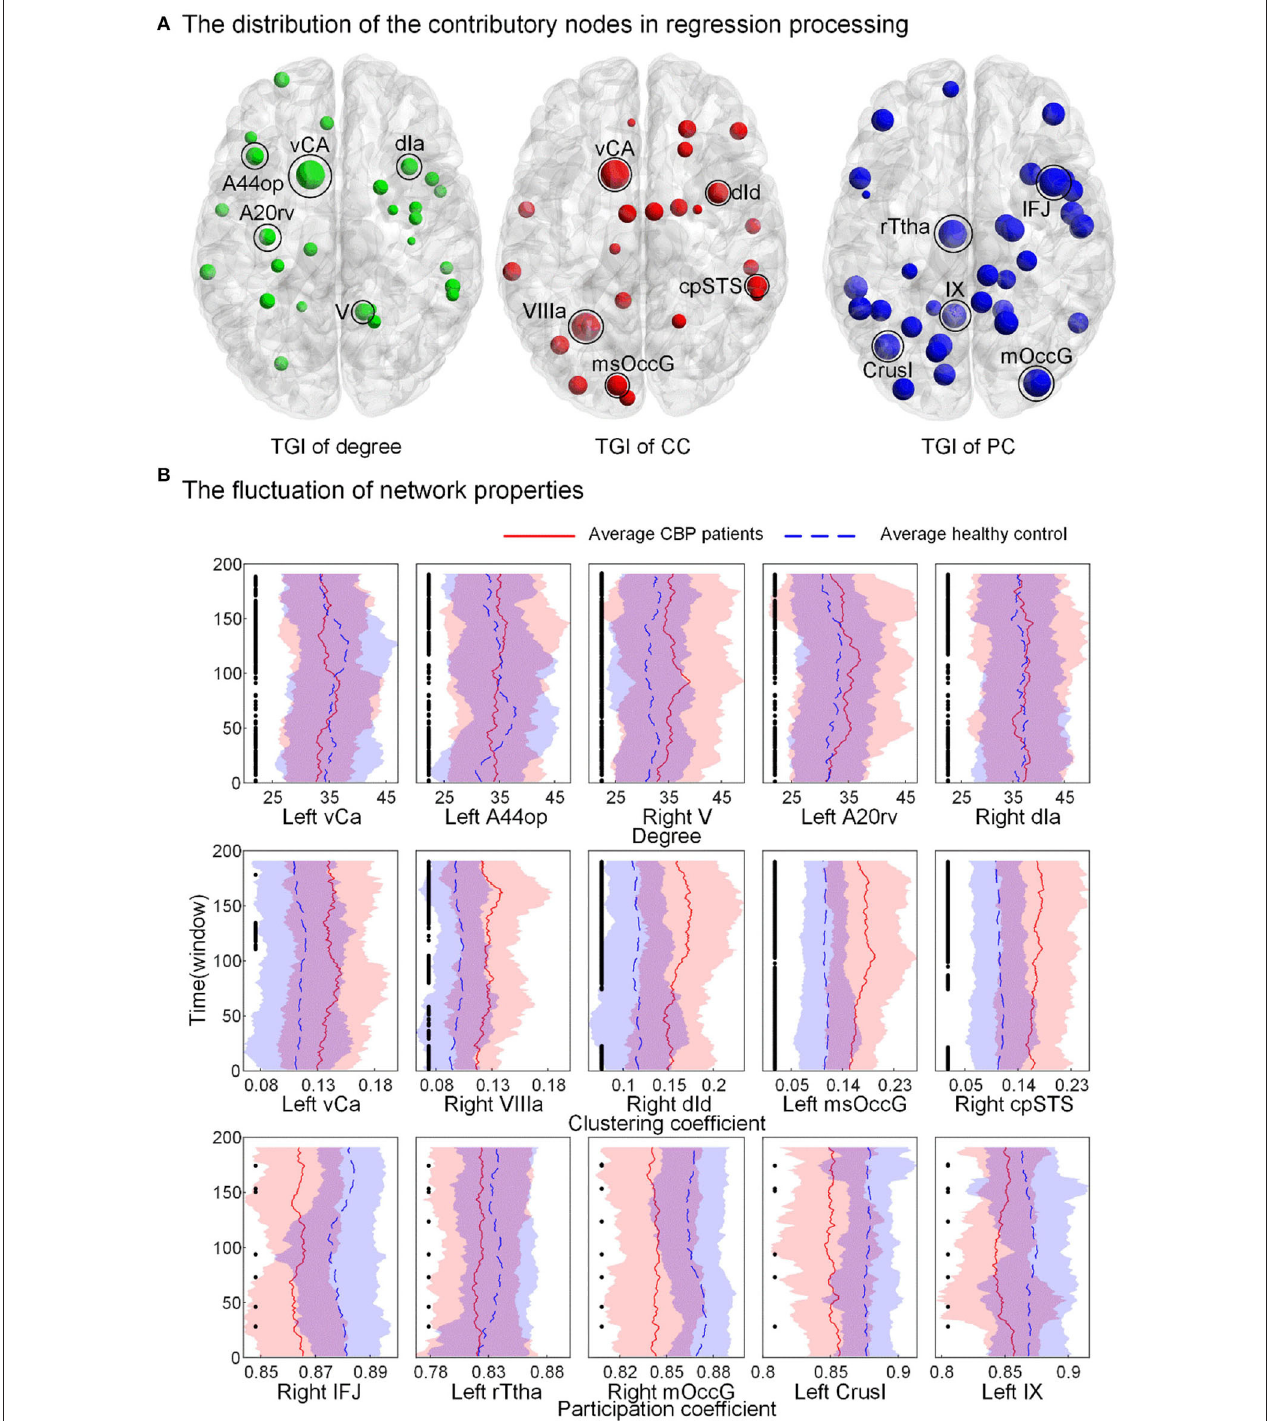
FIGURE 5 | Brain regions have high prediction power and the fluctuation of their nodal topology over time. (A) The weight of nodes contributed to the prediction process. Larger nodal size indicates a higher weight. (B) The fluctuation of network properties [nodal degree, clustering coefficient (CC), and participation coefficient (PC), not TGI] of the five nodes with the highest weights. The black point indicates a significant between-group difference ( p < 0.05, FDR corrected). vCa, ventral caudate; A44op, opercular Broca’s area (opercular Brodmann area 44); V, cerebellum lobule V; A20rv, rostroventral inferior temporal gyrus (rostroventral Brodmann area 20); dIa, dorsal agranular insula; VIIIa, cerebellum lobule VIIIa; dId, dorsal dysgranular insula; msOccG, medial superior occipital gyrus; cpSTS, caudoposterior superior temporal sulcus; IFJ, inferior frontal junction; rTtha, rostral temporal thalamus; CrusI, cerebellum lobule Crus I; IX, cerebellum lobule IX.